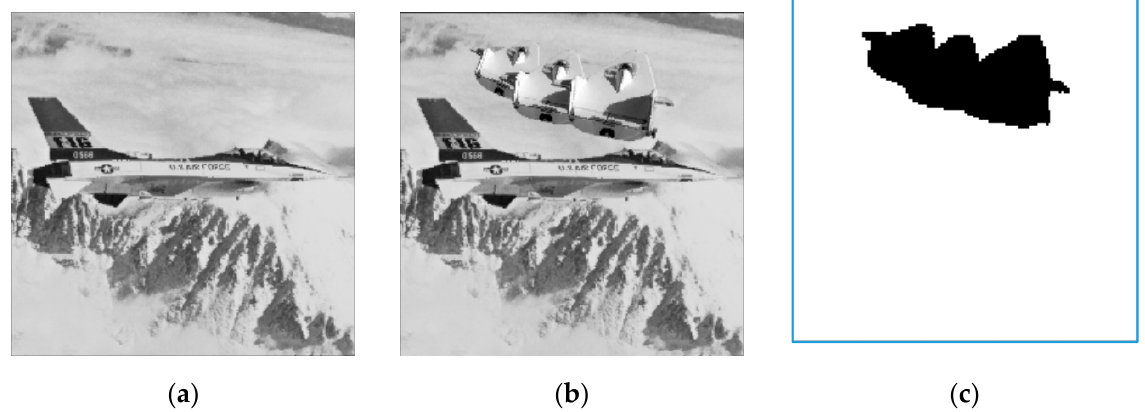
Figure 8. The tampering of the Jet image. (a) Marked image; ( b ) Tampered image; ( c ) Tampered